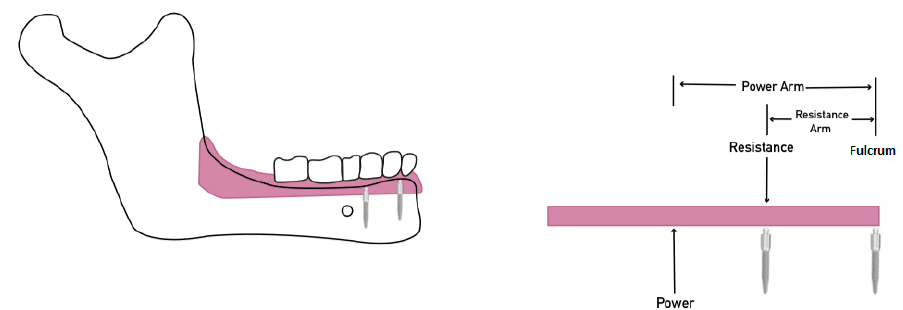
Figure 4. Class II lever system with anterior MDI act as a fulcrum, posterior MDI act as a resistance and the power is the posterior dislodging force. Placement of posterior MDI create a resistance point; notice the long resistance arm resulting from widely placing MDIs improving the mechanical advantage.